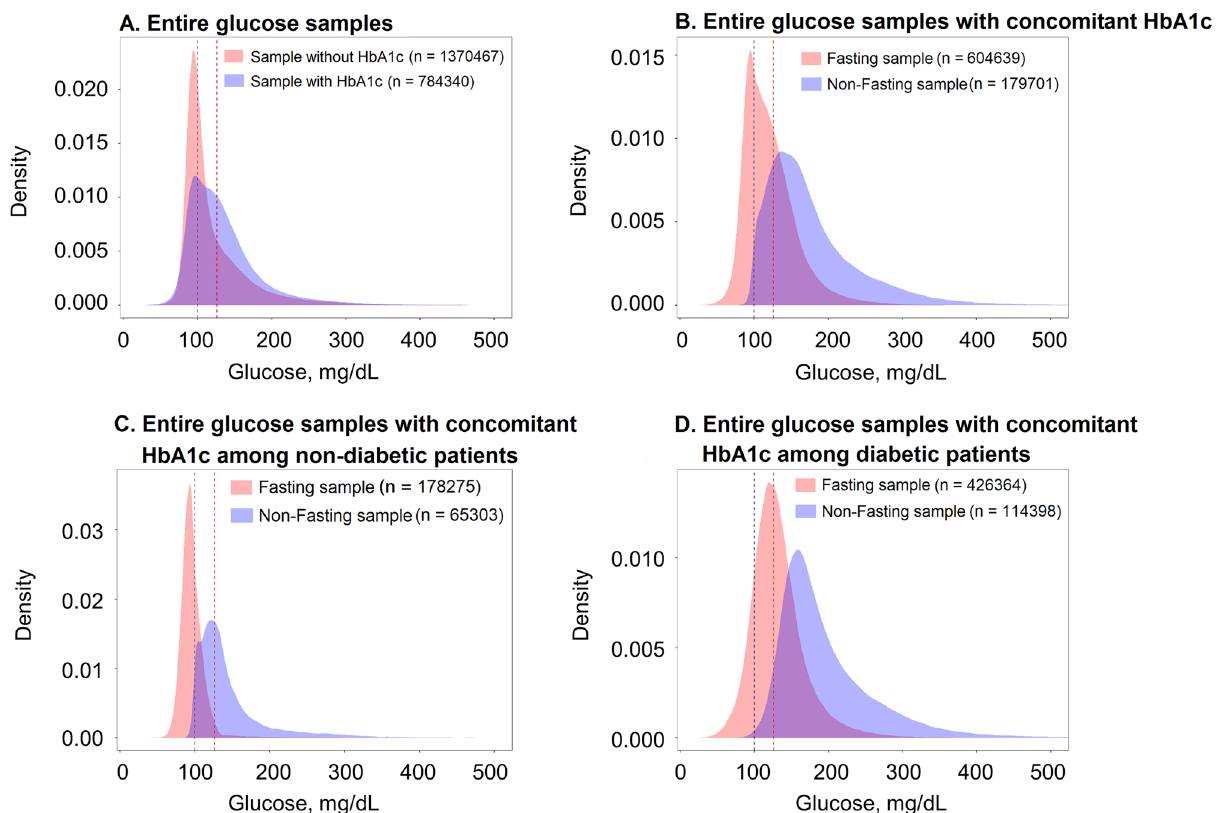
Figure 2. Density plots of ontological glucose AC in selected samples as follows: ( A ) entire samples stratified by the availability of HbA1c measured on the same day; ( B ) samples with HbA1c measured on the same day, stratified by theoretical fasting and nonfasting status; ( C ) the entire samples with A1c measured on the same day, stratified by fasting and nonfasting status in patients without DM; ( D ) the entire samples with HbA1c measured on the same day, stratified by fasting and nonfasting status in patients with DM. The dark blue dashed line shows the glucose value at 100 mg/dL, and the red dashed line shows the glucose value at 126